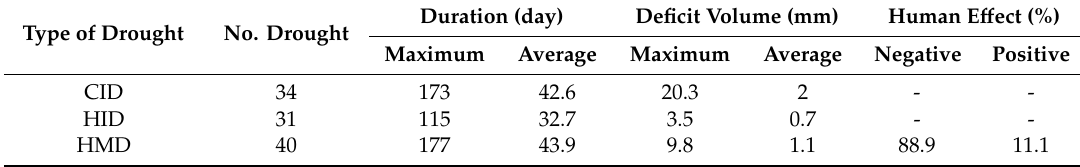
Table 5. Discharge drought characteristics for Kiakola (threshold = 80th